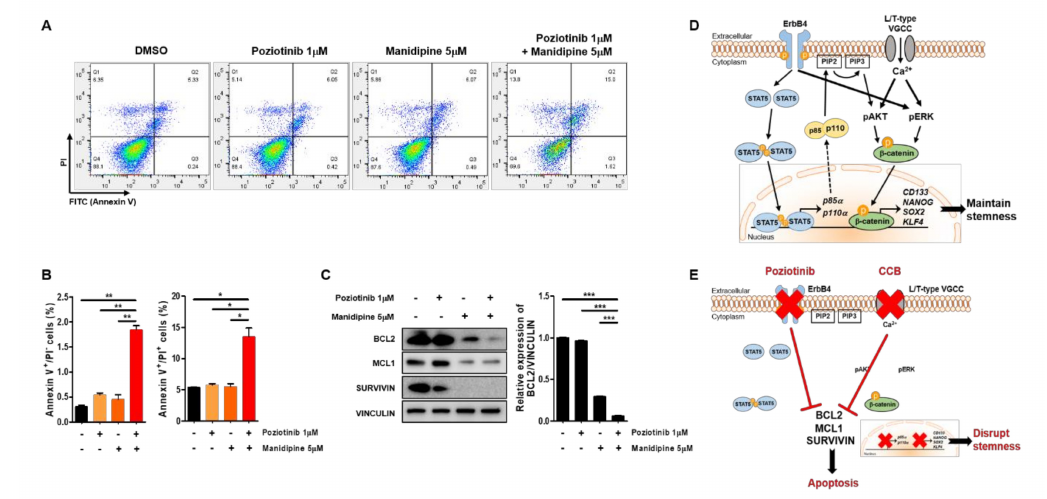
Figure 5. Apoptosis of ovarian CSCs induced by poziotinib and manidipine alone or in combination. ( A ) Apoptosis was analyzed by annexin V (AV) / propidium iodide (PI) staining in A2780-SP cells 24 h after treatment with the indicated concentrations of drugs. ( B ) The percentages of AV + / PI − and AV + / PI + cells are expressed as the mean ± SD of two or three independent experiments. * p < 0.05, ** p < 0.01, *** p < 0.001. ( C ) The expression of proapoptotic proteins was detected in A2780-SP cells treated with poziotinib and manidipine by Western blotting. The results of BCL2 expression are shown in a graph (right panel). The data are expressed as the mean ± SD of three independent experiments. * p < 0.05, ** p < 0.01, *** p < 0.001. ( D ) Schematic representation of the mechanisms of stemness maintenance in ovarian CSCs. ( E ) Schematic representation of the mechanisms of poziotinib and manidipine action in ovarian